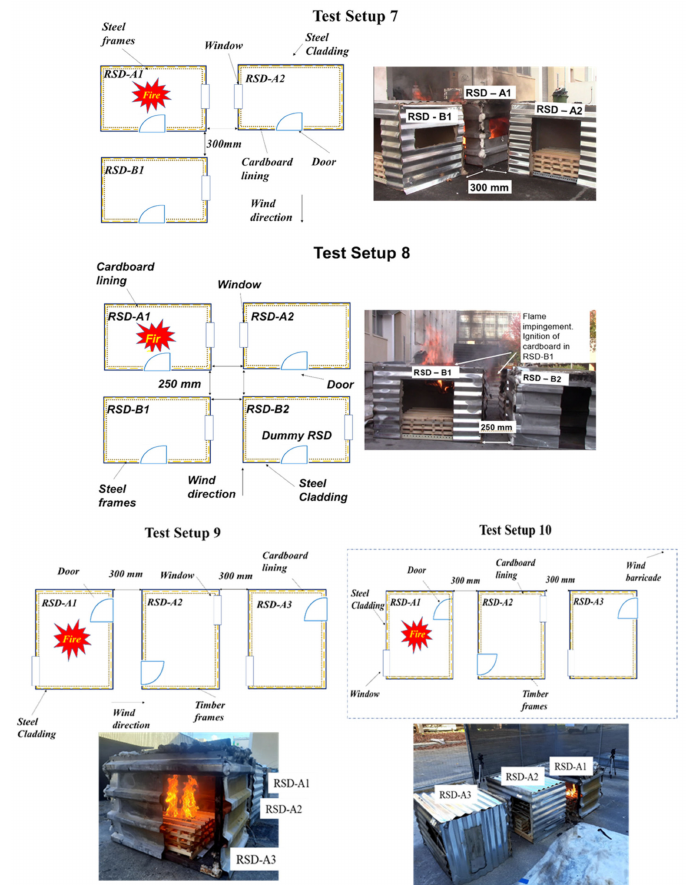
Figure 8. Tests 7 to 10 showing layouts and images during